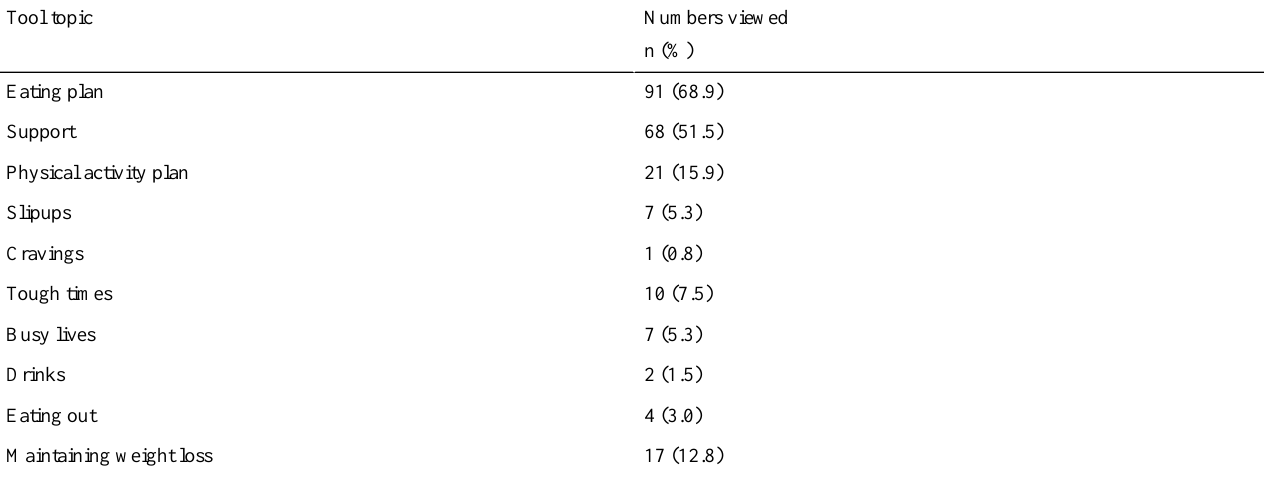
Table 4. Numbers of participants who reused POWeR tools.